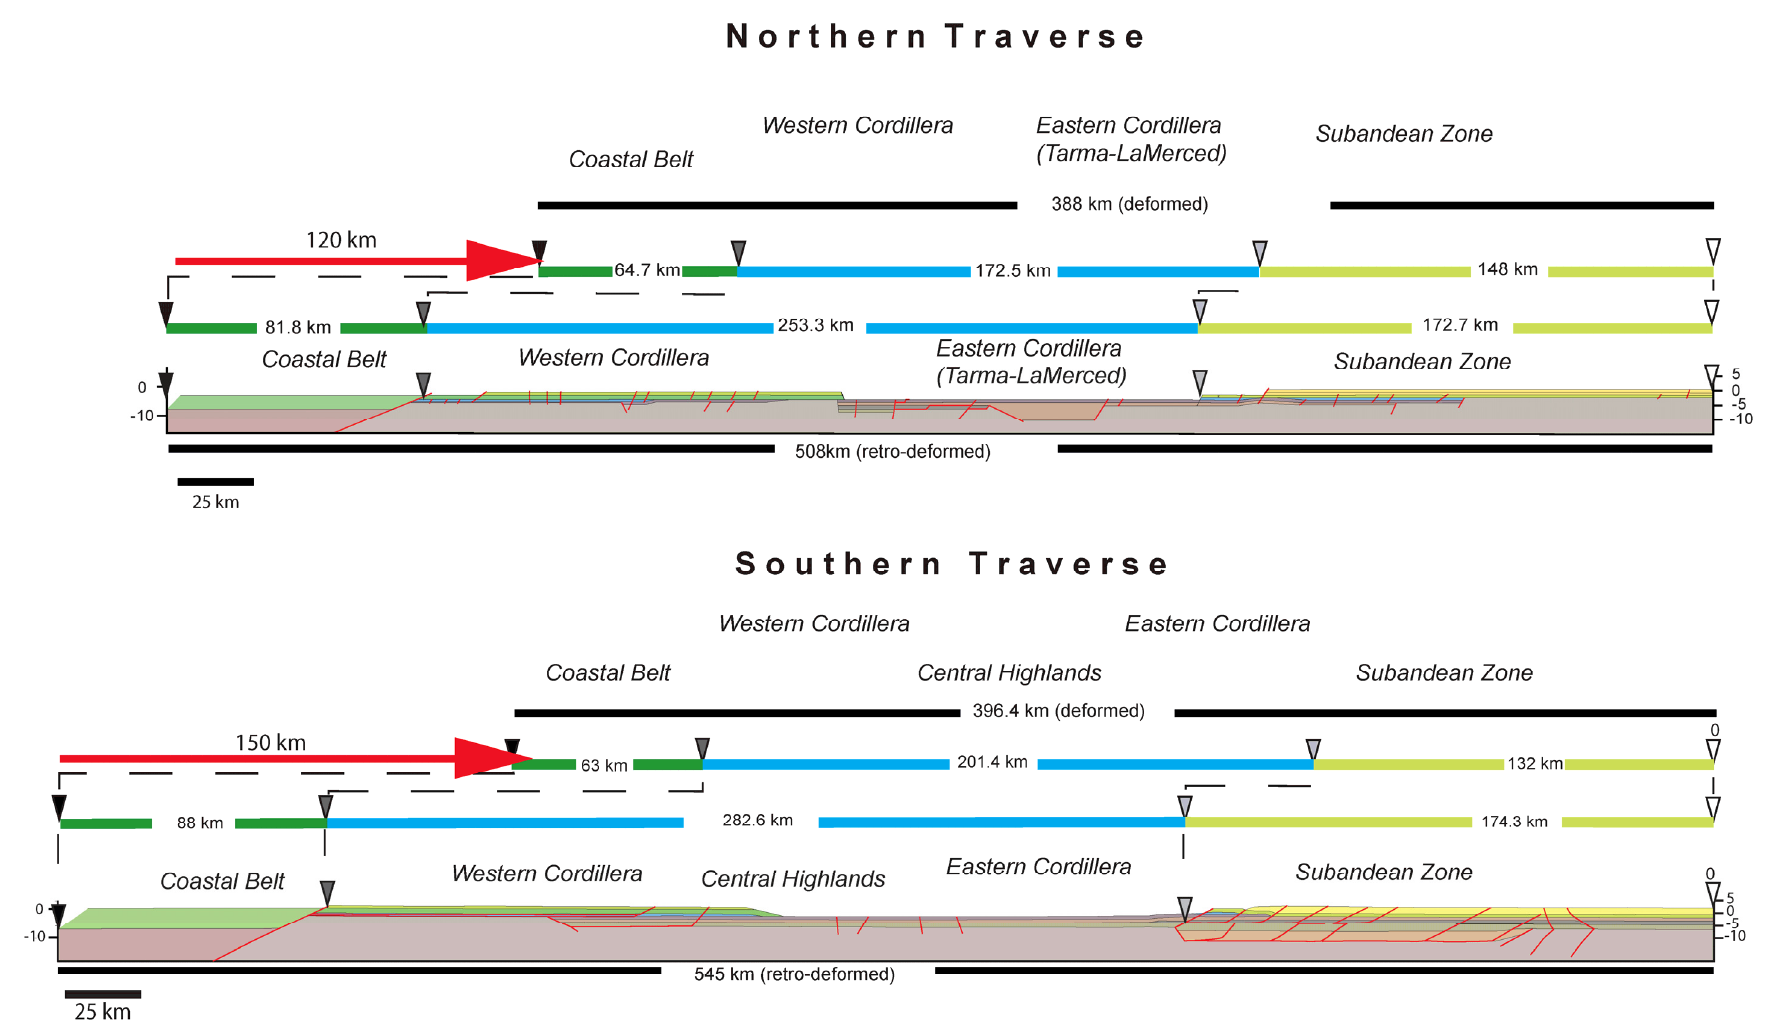
Figure 16. Retro-deformed cross-sections of the Northern and Southern traverses. Retro-deformed lengths, shortening and actual lengths are given in kilometers. The restored sections show the geometry of the Paleozoic, Mesozoic and Cenozoic basins. An enlarged version of this figure is available in the supplementary material (Figure